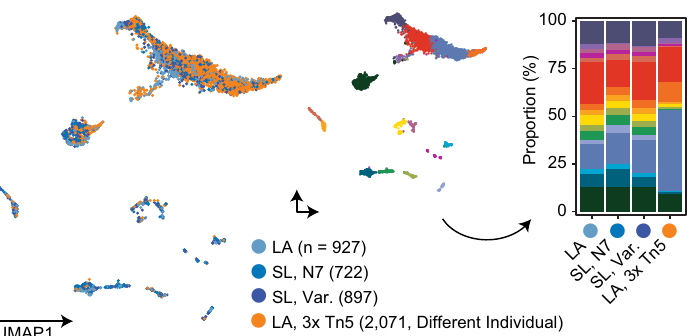
cluster composition of each method (right). c Integration with a sciMETv2.LA dataset produced using three sets of 96 indexes at the tagmentation step per- formed on a different individual. Cells from each method were present in each cluster, though greater counts of glial cells were observed in the new